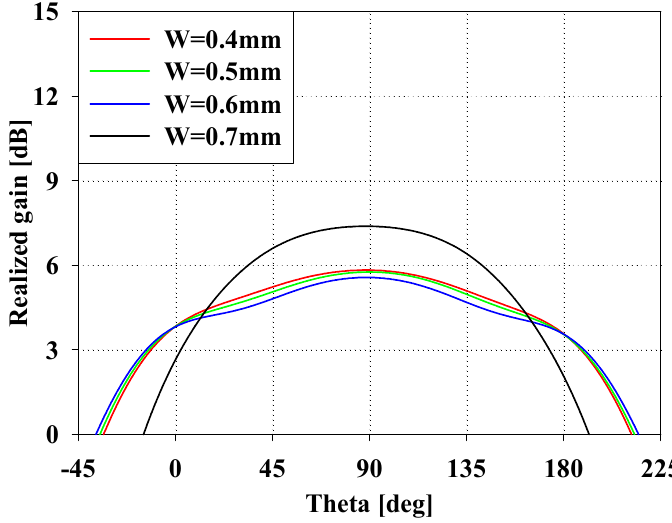
Figure 5. Realized gain for various values of the slot width (W).